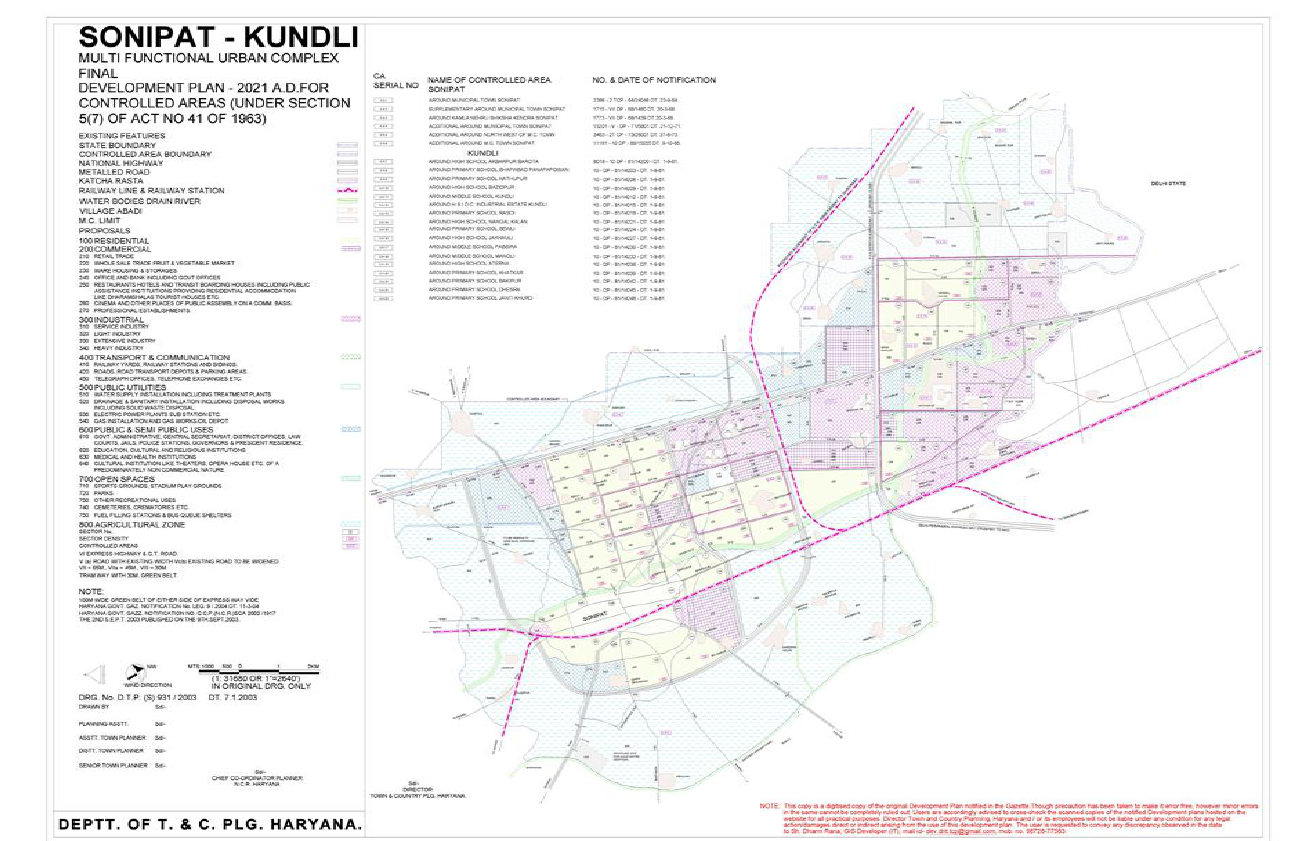
Figure 3. Final Development Plan: Sonipat-Kundli District, Haryana,